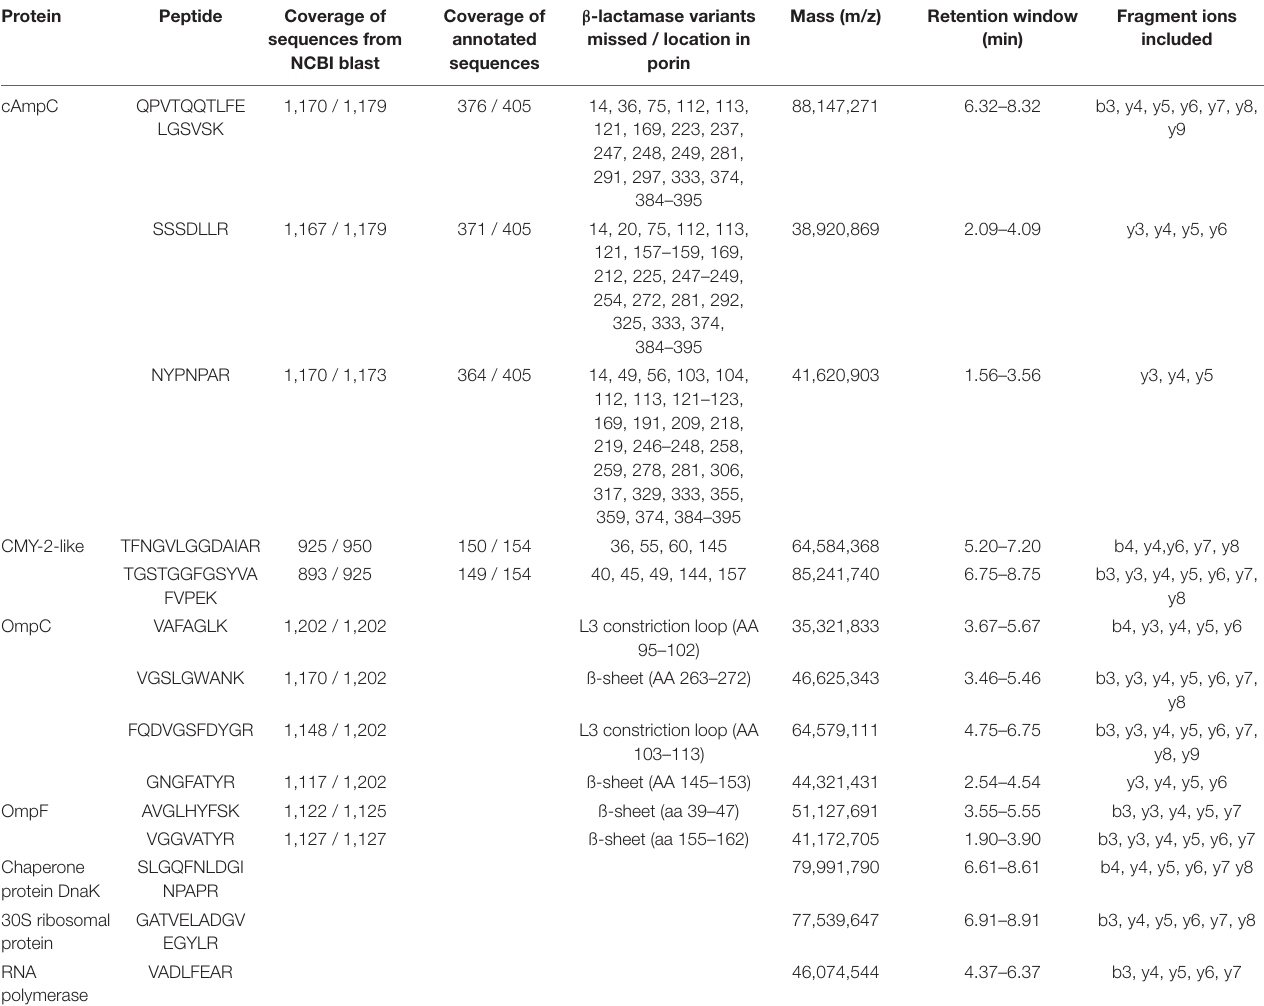
TABLE 1 | In total, 14 peptides were selected and included in a multiplex LC-MS/MS assay for the detection of the β -lactamases cAmpC and CMY-2-like, the porins OmpC and OmpF, and three “housekeeping” proteins for quality control purpose. Protein Peptide Coverage of sequences